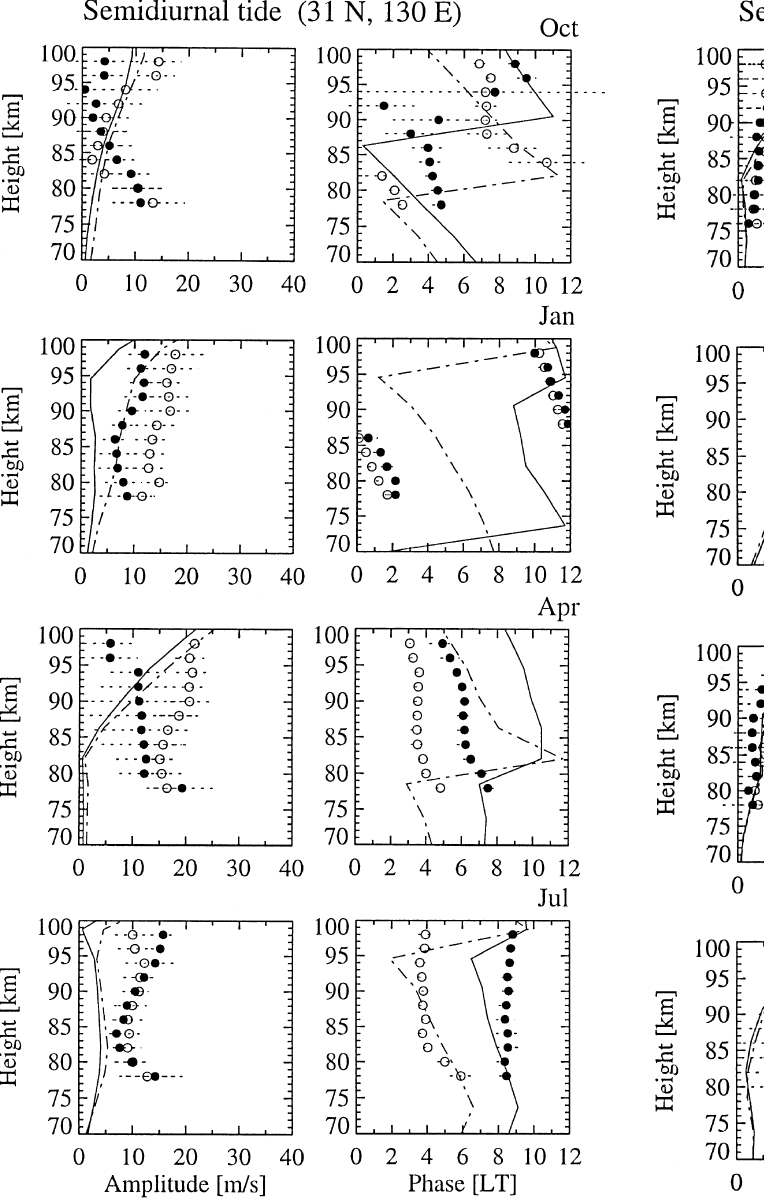
Fig. 7. Same as Fig. 5 but for the semidiurnal tide at Yamagawa (31 (cid:176) N) Fig. 8. Same as Fig. 5 but for the semidiurnal tide at Wakkanai